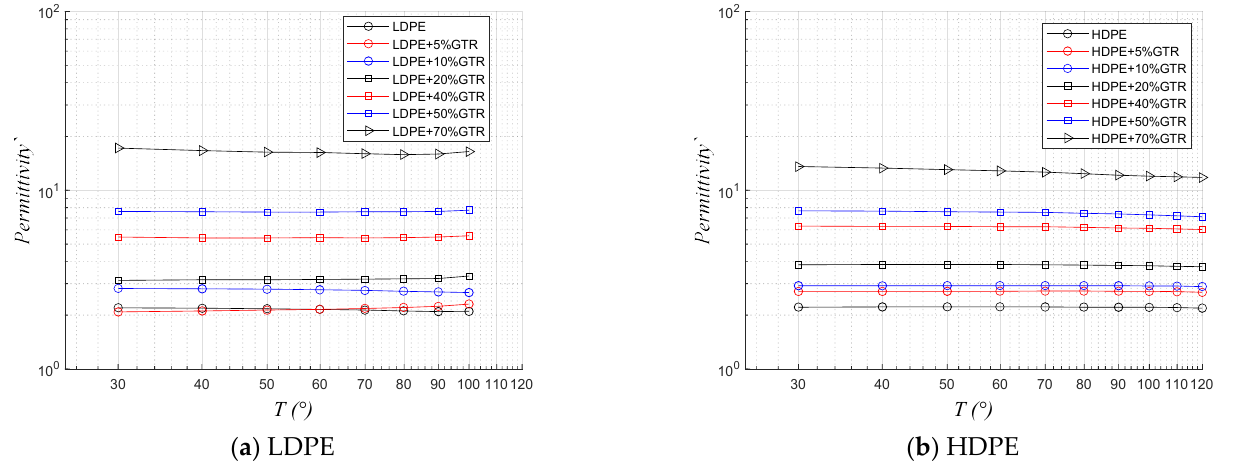
Figure 7. Thermal response of real permittivity ( ԑ ’) with a temperature range of 30 to 100 °C, at 50Hz, of ( a ) LDPE/GTR compounds and ( b ) HDPE/GTR compounds.